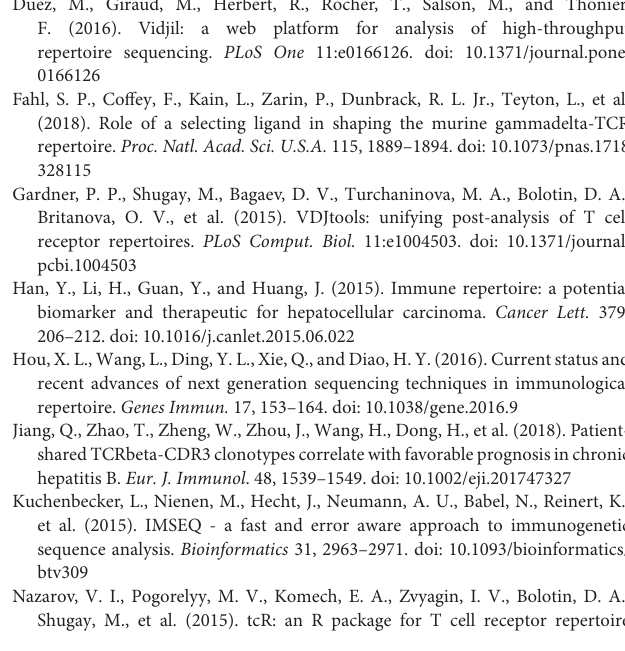
TABLE S1 | TCR sequencing data analysis methods in VisTCR